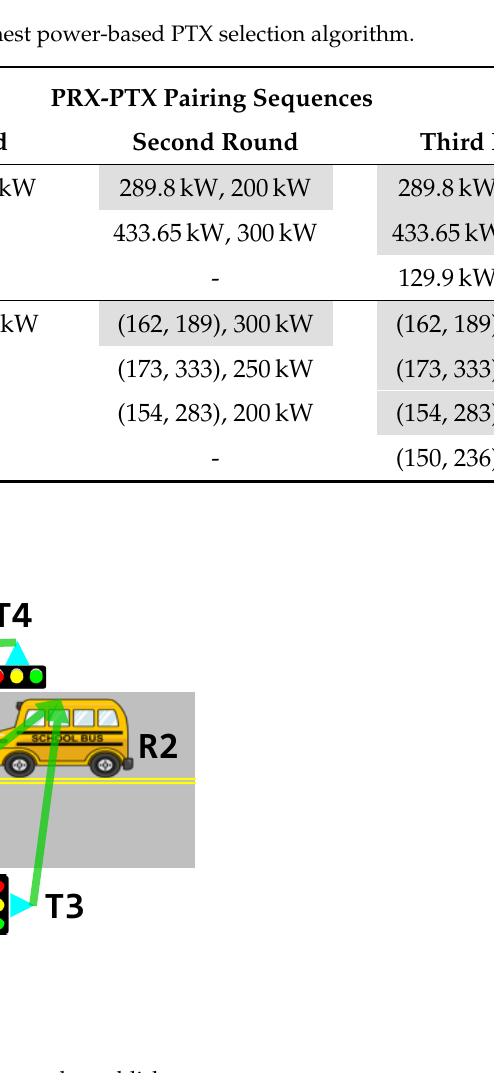
Figure 14. Results of power transmission path